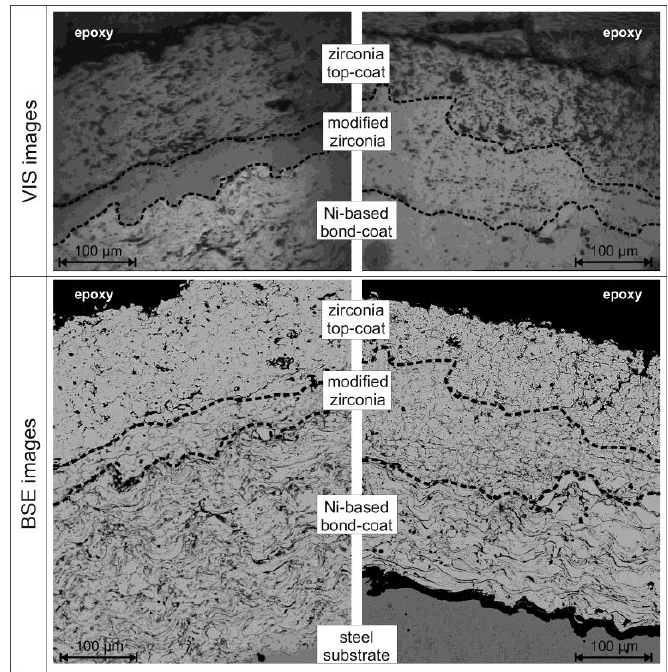
Figure 3. Reflected light (VIS) and back-scattered electron (BSE) images of an uncooled test probe TP 1 (700 ◦ C) (left) and a cooled test probe TP 2.1 (450 ◦ C) (right).